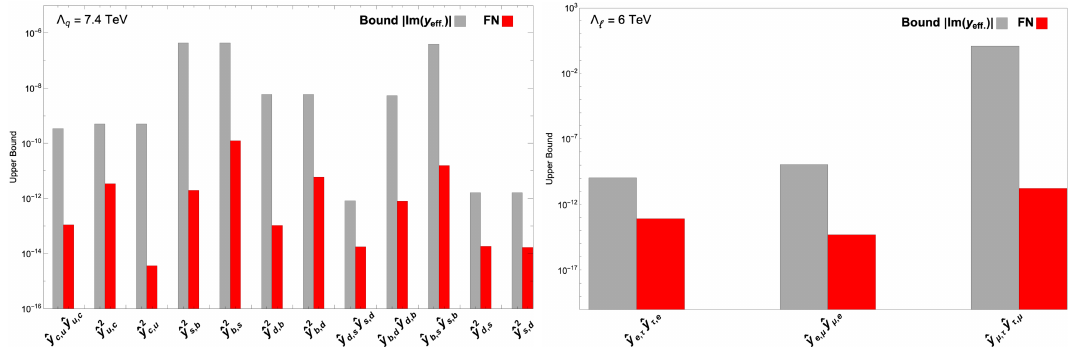
Figure 4 . Graphical representation of the experimental bounds and FN predictions on the effective Yukawas for the case with large CP phases. In the first plot the results in the quark sector: in grey the bounds on the imaginary part of the combination of the effective Yukawas from table 10, and in red the prediction of the FN model assuming Λ q = 7 . 4 TeV. The second plot shows the results in the lepton sector: in grey the bounds on the Imaginary part from table 11, while the FN predictions are in red assuming Λ ‘ = 6 . 0